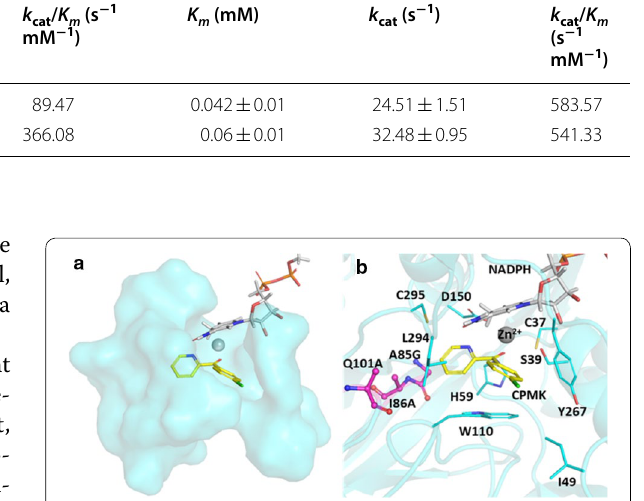
Table 4 Kinetic parameters of TbSADH mutants towards substrate 1 Enzymes